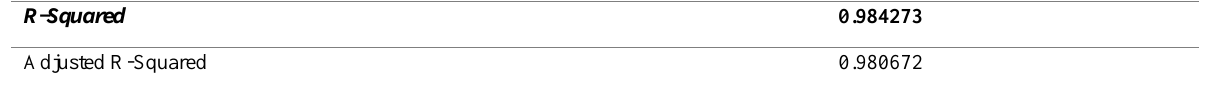
Table 7: R-Squared and Adjusted R-Squared Test